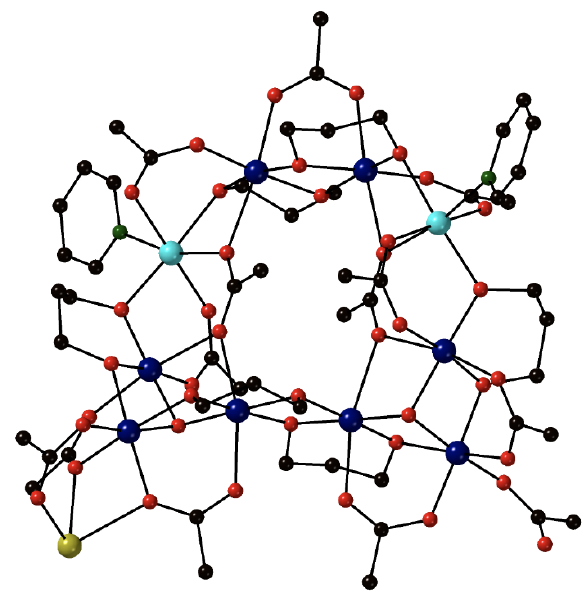
Figure 20. Τhe structure of one {Mn II2 Mn III8 NaO 2 (O 2 CMe) 13 (pd) 6 (py) 2 } loop that is present in 32 . Color code: Mn II cyan, Mn III dark blue, Na + dark yellow, O red, N green. Modified from reference [138].